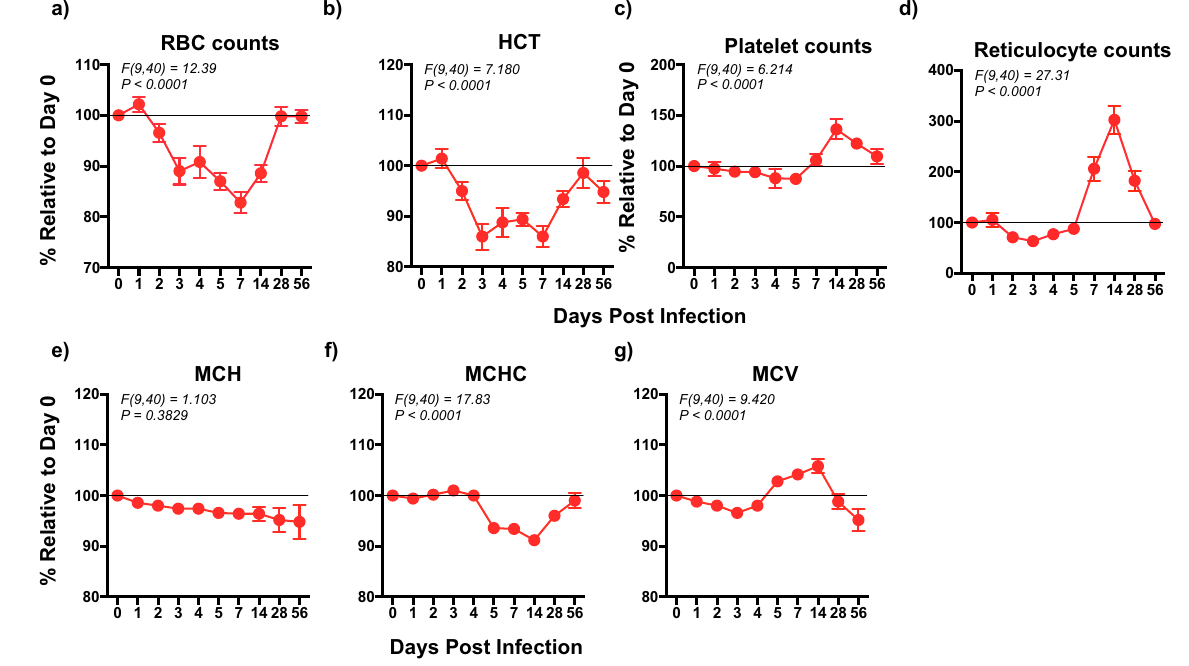
Figure 3. Red blood cell indices significantly decline during the acute phase of coinfection with ZIKV and DENV- 2. Kinetics of ( a ) Red blood cell counts (RBC counts), ( b ) Hematocrit (HCT), ( c ) Platelet counts, ( d ) Reticulocyte counts, ( e ) Mean Corpuscular Hemoglobin (MCH), ( f ) Mean Corpuscular Hemoglobin Concentration (MCHC), and ( g ) Mean Cell Volume (MCV) in serum that was collected longitudinally from rhesus macaques (n = 5) coinfected with ZIKV and DENV-2. Line represents day 0 values. Statistical differences were determined using One- way ANOVA and a p < 0 . 05 was considered significant. Error bars represent standard Red blood cell indices are significantly lower during the early acute phase of coinfection with ZIKV and DENV-2. To determine if coinfection was associated with changes in the red blood cell indices, we examined red blood cell (RBC), reticulocyte and platelet counts, hematocrit (HCT), Mean Corpuscular Hemoglobin (MCH), Mean Corpuscular Hemoglobin Concentration (MCHC), and Mean Cell Volume (MCV) following coinfection with ZIKV and DENV-2 and compared them to preinfection values (Fig. 3a–g). We observed a significant drop in RBC counts ( F(9 , 40) = 12 . 39 , p < 0 . 0001 ) and HCT ( F(9 , 40) = 7 . 180 , p < 0 . 0001 ) by day 2 PI that remained significantly lower till day 14 PI and recovered to baseline levels by day 28 PI (Fig. 3a,b). In contrast to RBC counts, platelet counts ( F(9 , 40) = 6 . 214 , p < 0 . 0001 ) declined marginally during the 1 st 5 days of infection after which it increased significantly by day 7 PI and remained above baseline levels till day 56 PI (Fig. 3c). Interestingly, reticulocyte counts ( F(9 , 40) = 27 . 31 , p < 0 . 0001 ) showed a significant decline relative to baseline during the 1 st 5 days after infection and then significantly increased by day 7 PI to peak at day 14 PI and returned to baseline levels by day 56 PI (Fig. 3d). Previous studies have reported that 2/12 patients coinfected with ZIKV and DENV experienced a decline in platelet counts 20 . MCH that measures hemoglobin (Hb) amount/red cell showed a steady decline and stayed below baseline levels during the 56 days of infection though this difference was not significant due to variation between animals (Fig. 3e). On the other hand, MCHC ( F(9 , 40) = 17 . 83 , p < 0 . 0001 ), which is a measure of the amount of Hb relative to cell size, remained at baseline levels till day 4 PI after which it significantly declined and stayed low till day 28 PI after which it recovered to near baseline levels by day 56 PI (Fig. 3f). MCV ( F(9 , 40) = 9 . 420 , p < 0 . 0001 ) which is a measure of the average size of red cells marginally declined steadily till day 4 PI relative to baseline and then significantly increased at day 5 PI and stayed high till day 14 PI after which it declined to below baseline levels by day 56 PI (Fig. 3g). Taken together, the hematological changes described above suggests that coinfection with ZIKV and DENV-2 was associated transient anemia during the acute phase of infection. The average body weight of the 5 animals (~7.2 Kg) used in the study did not change over the course of 8 weeks of infection. Additionally, minimal blood volumes were collected at each of the time points suggesting that these changes were not likely due to sampling. Coinfection with ZIKV and DENV-2 is associated with a significant increase is pro-inflammatory cytokines during the course of infection. Previous studies have shown that high levels of pro-inflammatory mediators was associated with increased pathogenesis of flavivirus infections 53,54 . To determine